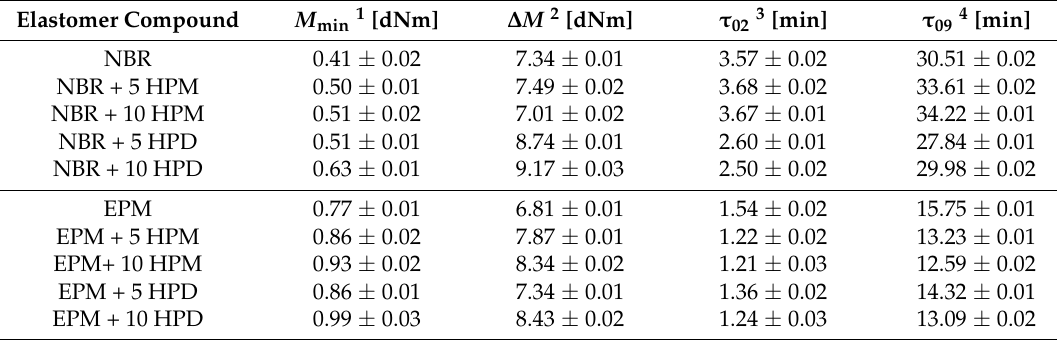
Table 4. Curing parameters of NBR and EPM compounds.